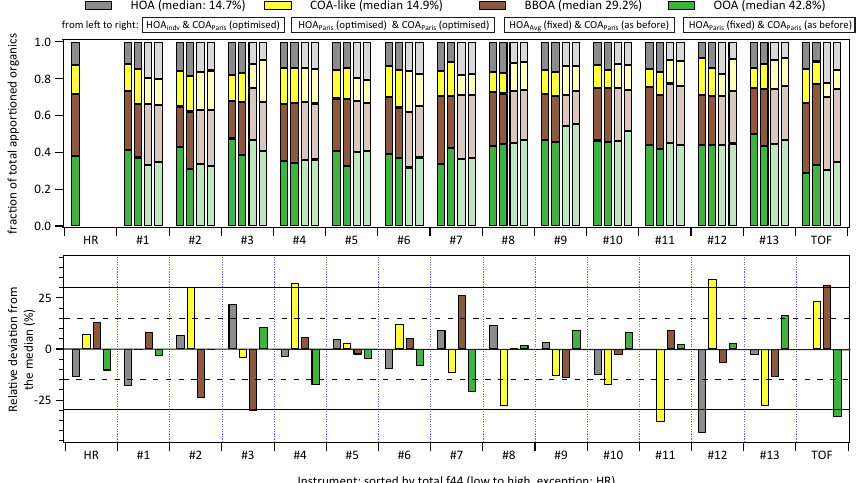
Instrument: sorted by total f44 (low to high, exception: Figure 7. (Top) Relative factor contributions of HOA (grey), COA-like (yellow), OOA (green) and BBOA (brown) for each of the 15 participating instruments sorted by f 44 in the corresponding total organic spectrum (low to high). Each time four bar plots are shown. Fully coloured: a values were optimised, lightly coloured: a HOA = 0 and a COA equal to value in the second fully coloured bar from the left (see Table 2). For each of the left-most bar plots HOA was either fully unconstrained or HOA indv extracted from a previous unconstrained PMF solution of the same data set. For the second bar the anchors HOA Paris and COA Paris were used and optimised in each case. For the third and fourth bar from the left COA Paris was used as anchor with the same a values as before while a HOA = 0. Different HOA anchors were used in the third (HOA Avg ) and the fourth (HOA Paris ) bars from the left. Median values of the left-most solutions are given in brackets in the legend. (Bottom) Relative deviation from the median in percent of each factor in each of the 15 instruments sorted by total f 44 (low to high). The solid line confines the ± 30% region and the dashed line the ± 15% region. Colours are the same as in the top